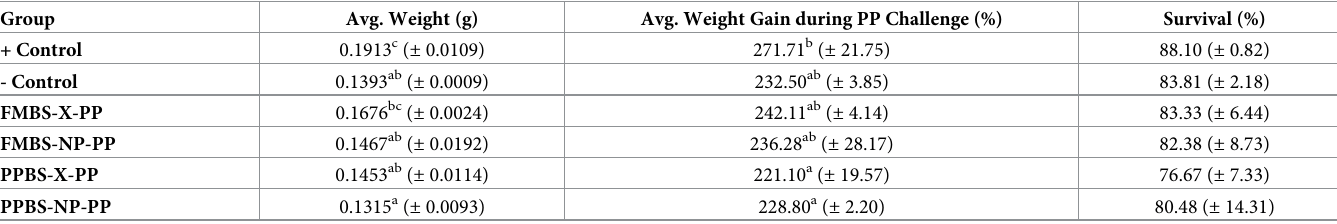
Table 3. Treatment effect on growth performance measures.